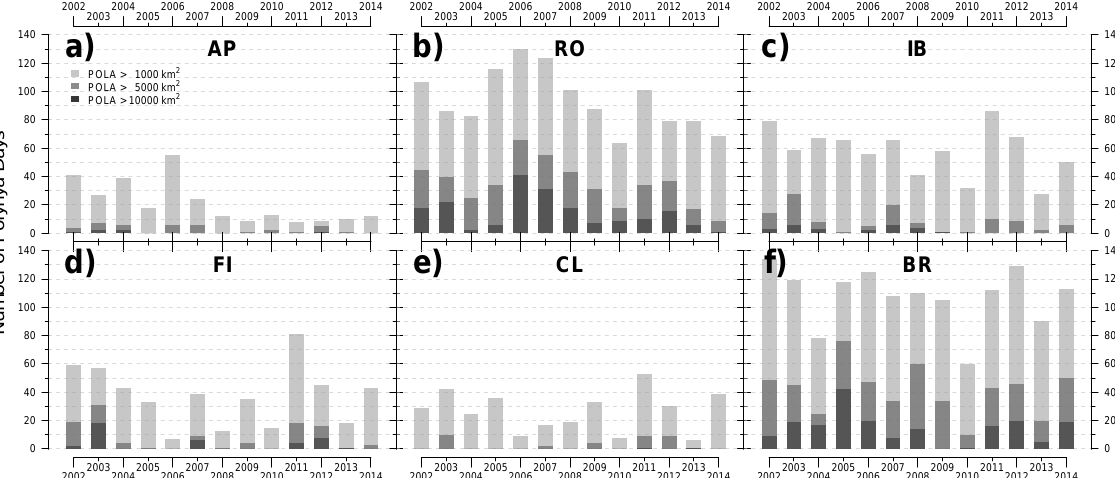
Figure 10. Number of days (polynya days) separated into three polynya area (POLA) classes (km 2 ) for the years from 2002 to 2014 during the winter period from April to